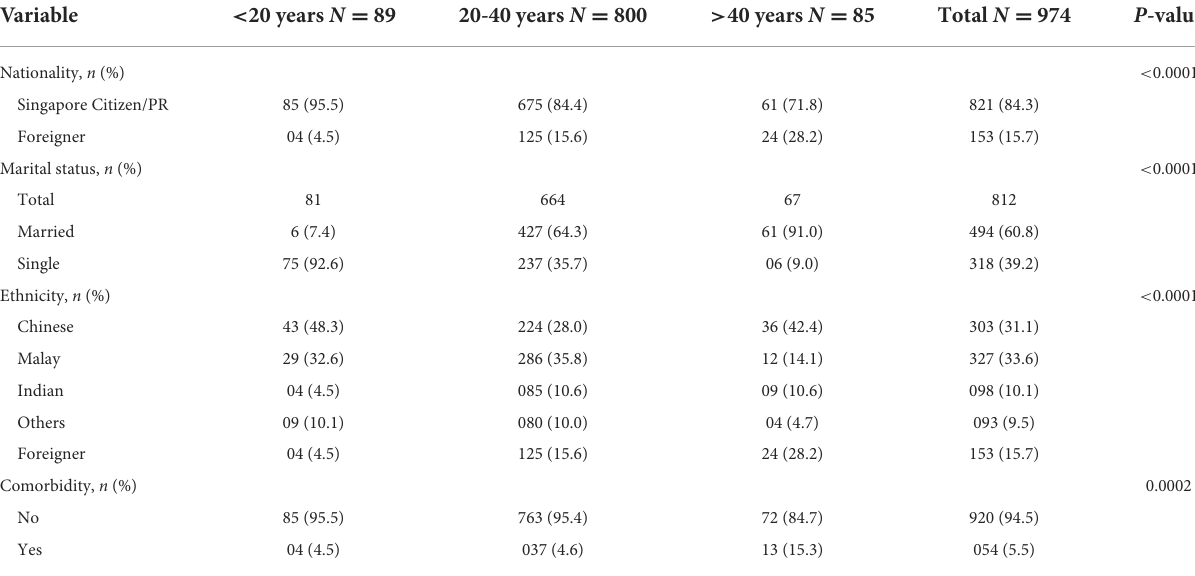
TABLE 4 Sub-analyses of women across three age groups requesting referrals for unintended pregnancies.